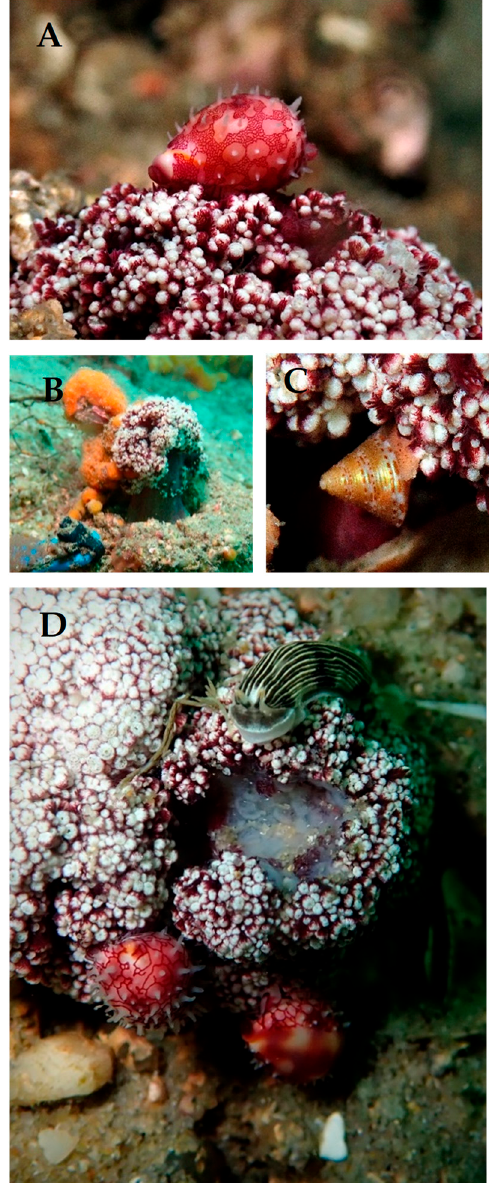
Figure 1. Example of species recruiting to transplanted nubbins of D. australis . ( A ): Diminovula culmen